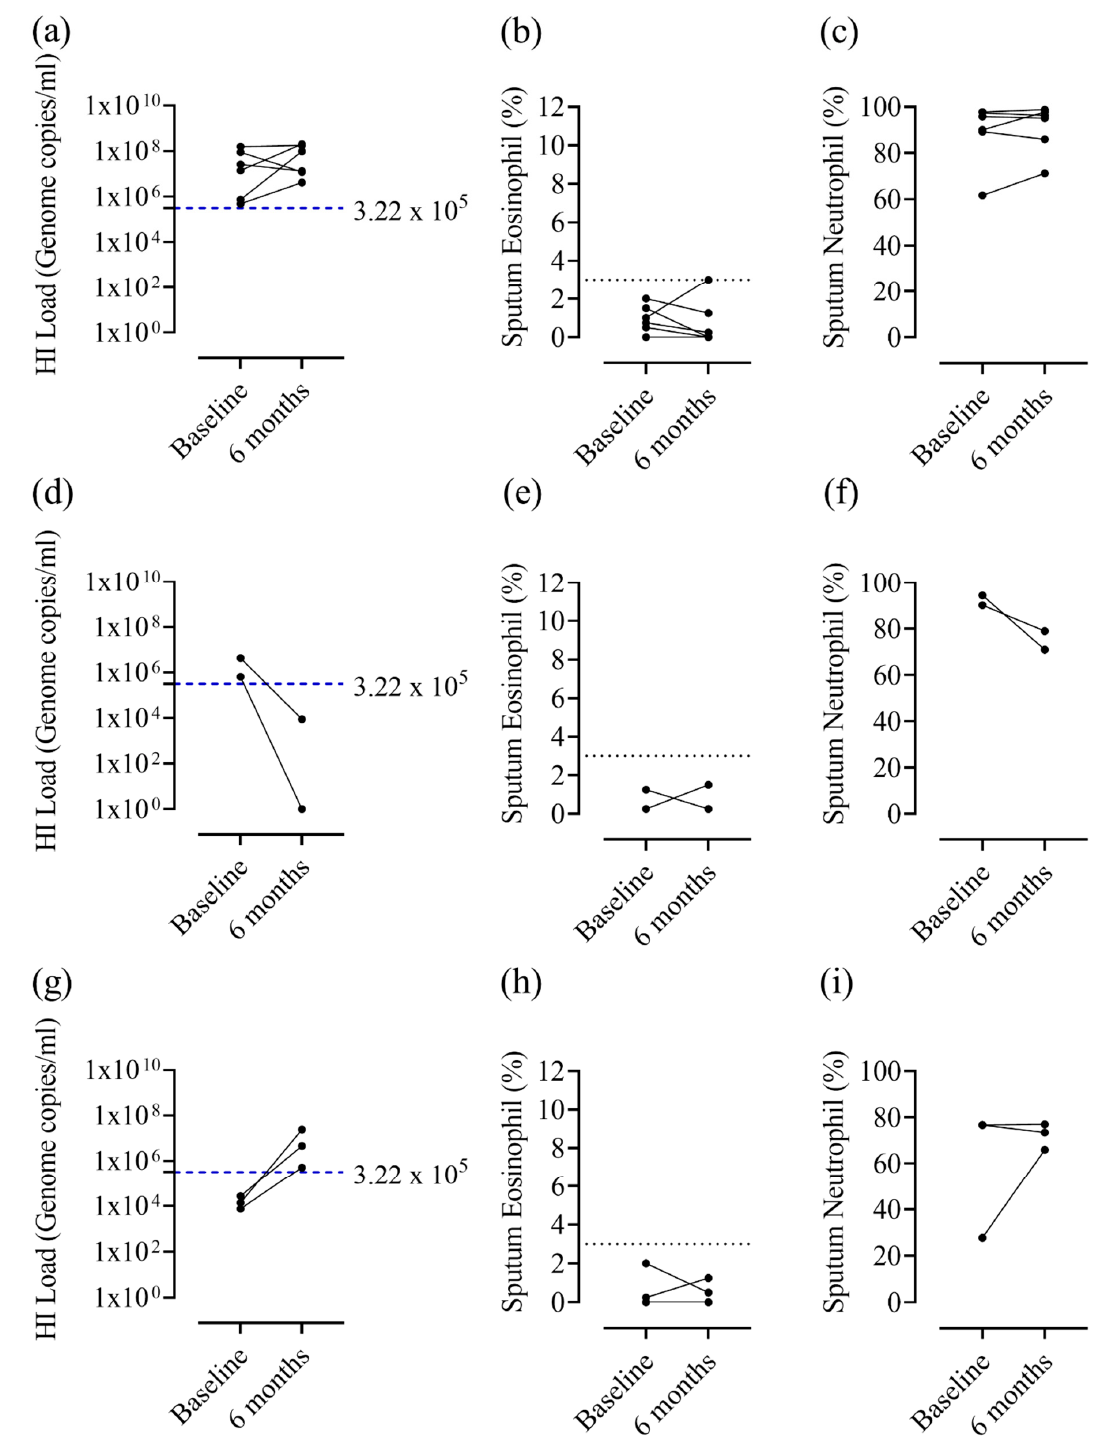
Figure 4. Haemophilus influenzae load, sputum neutrophil percentage and eosinophil percentage at baseline and 6-month visits for patients positive for H. influenzae at one or both visits. Sputum qPCR and differential cell counts were performed to determine H. influenzae load, sputum neutrophil % and eosinophil % at baseline and 6 month visits for patients positive for H. influenzae at ( a – c ) both visits, ( d – f ) baseline only or ( g – i ) 6 months only. The blue dashed line represents the upper threshold of the HNS range for H. Influenzae (3.22 × 10 5 genome copies/mL), while the black dotted line indicates 3% sputum eosinophils. HI, Haemophilus influenzae .